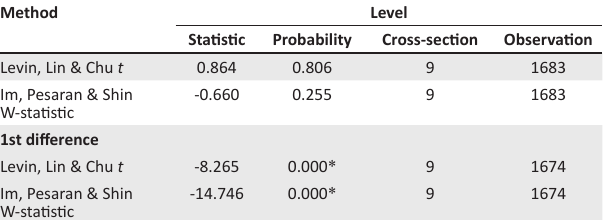
TABLE 2: Panel unit root test: Exchange rate volatility − with Generalised Autoregressive Conditional Heteroscedasticity. Method Level